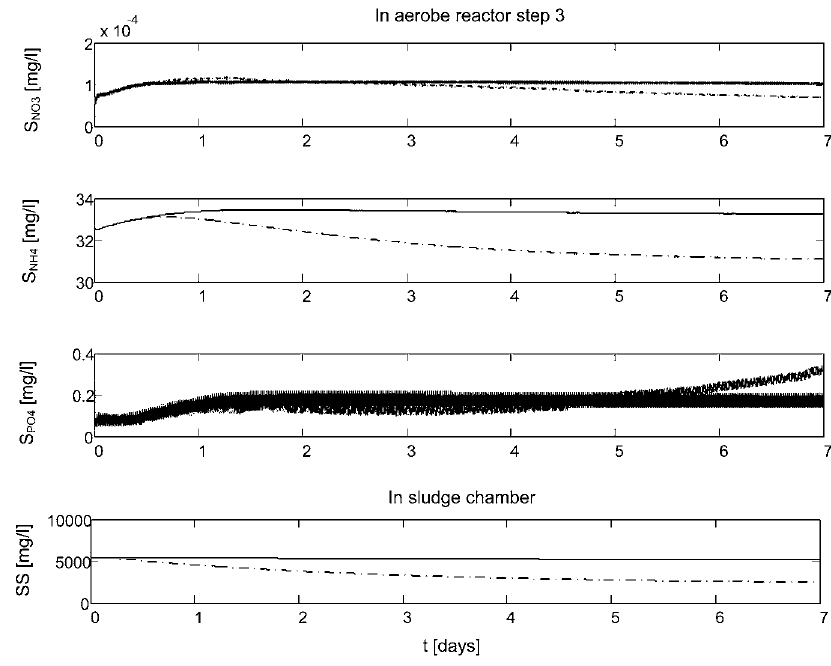
Figure 2. Simulated outputs S NO , S NH , S PO , and SS (cid:1) X A (cid:4) X H (cid:4) X PAO over 7 days, with sludge 3 4 4 ages T sludge (cid:1) 6 d (solid, black) and T sludge (cid:1) 2 d (dashed,